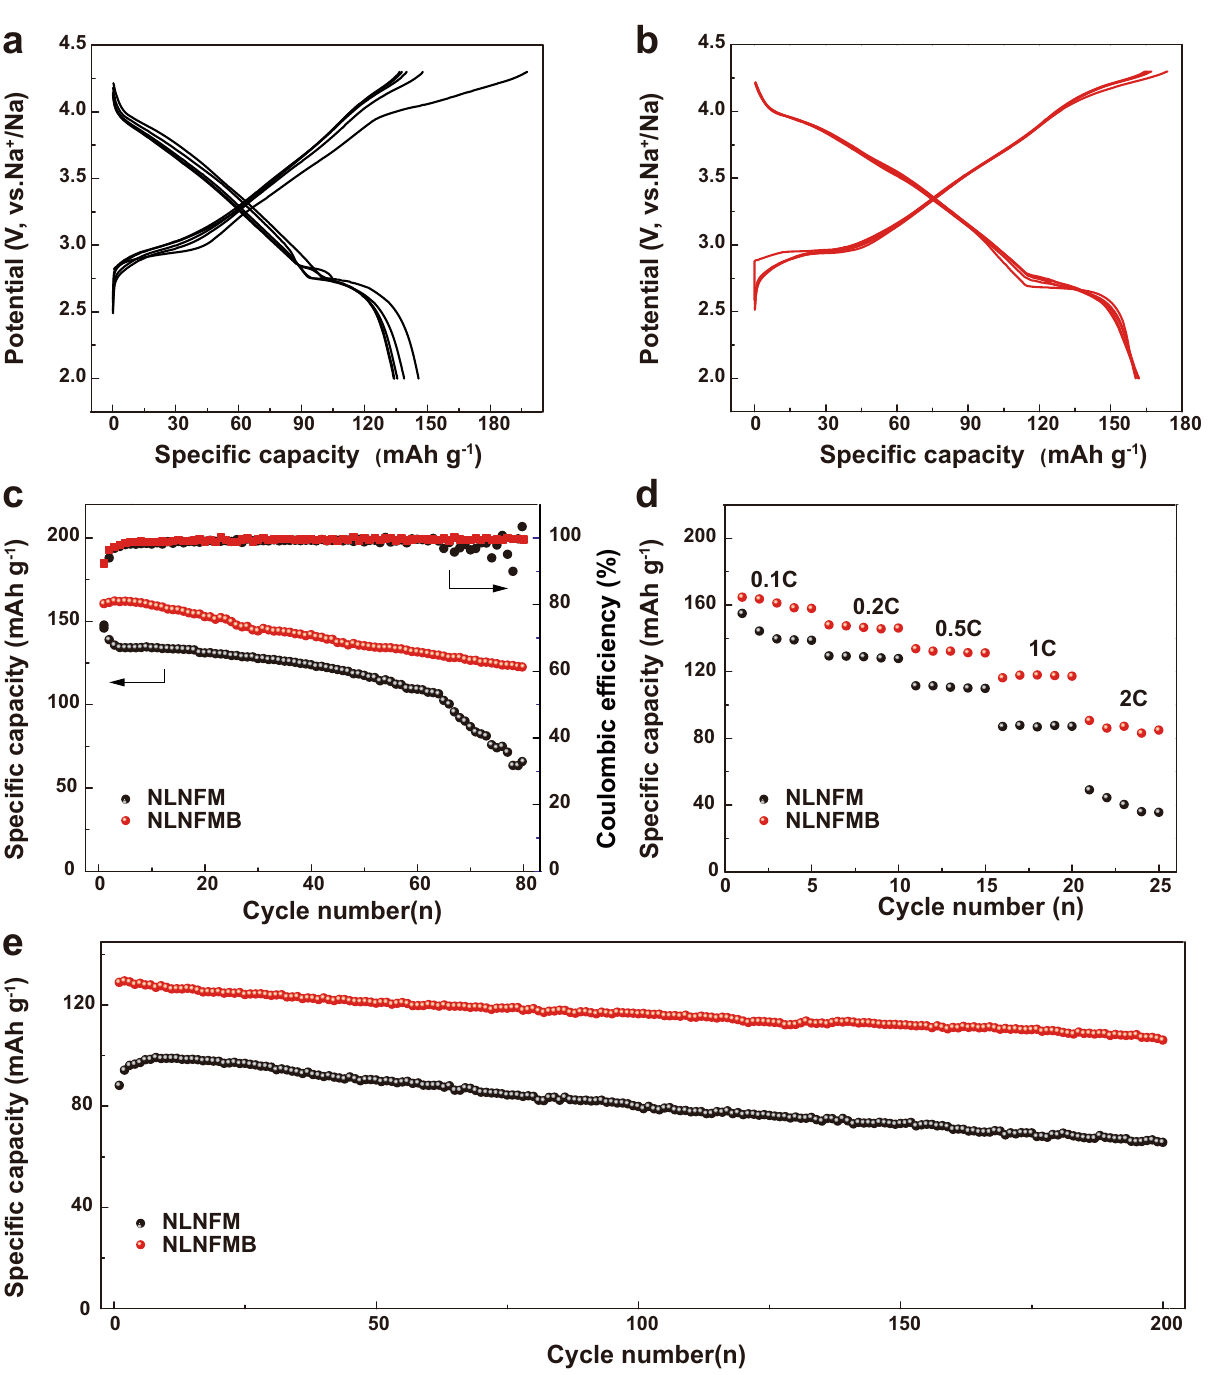
Fig. 4 Na-ion electrochemical energy storage performances in half-cell con fi guration at 25 °C. Galvanostatic charge/discharge voltage pro fi les of NLNFM ( a ) and NLNFMB ( b ) at 25 mA g − 1 between 2.0 and 4.3 V. Cycling performance at 25 mA g − 1 ( c ), rate capability at various charge-discharge